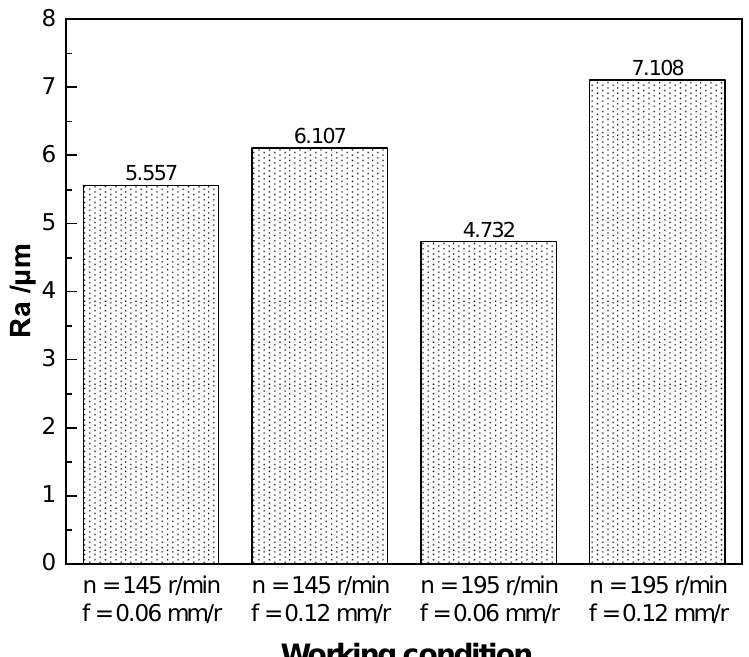
Figure 10. Hole surface